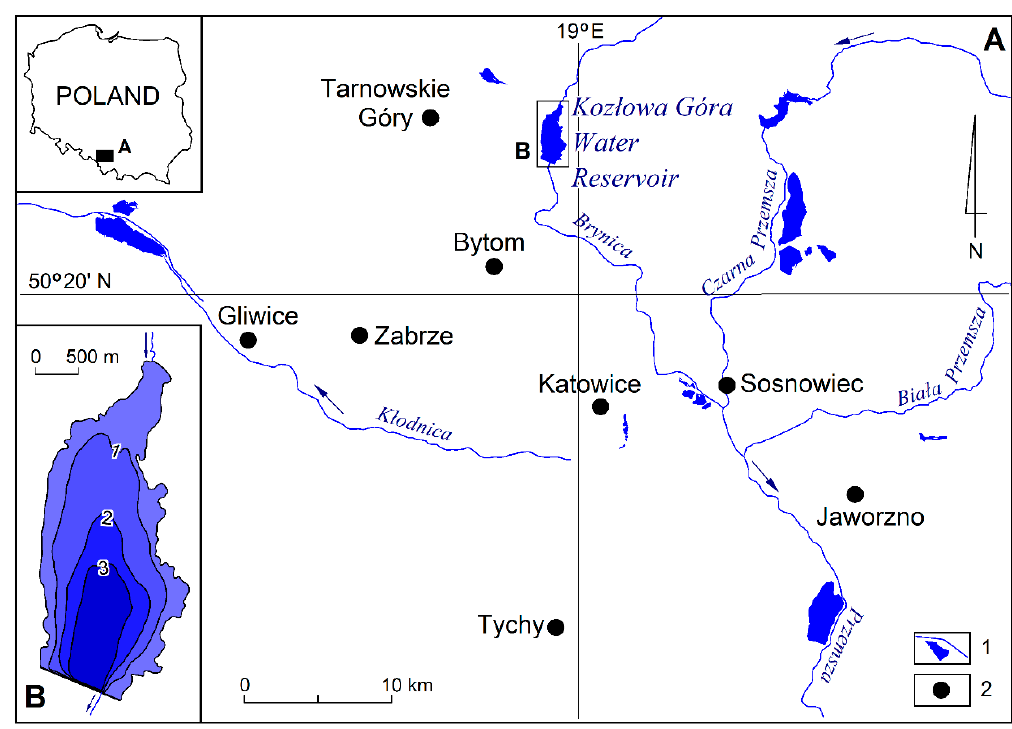
Figure 1. Location of the Kozłowa Góra reservoir ( A ) together with its bathymetric plan ( B ): 1—water courses and water reservoirs, 2—major cities.